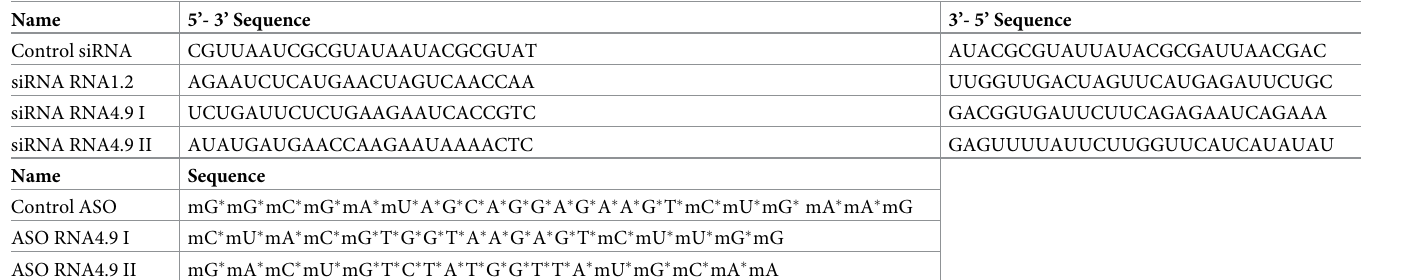
Table 3. Sequences of siRNAs and